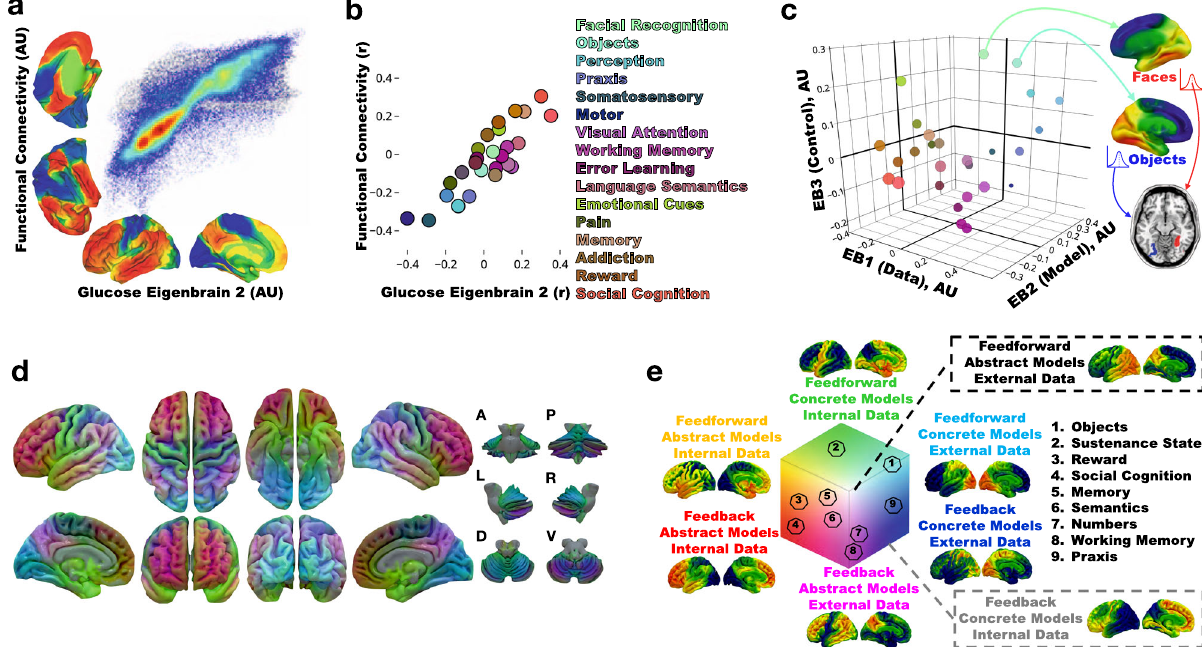
Fig. 3 Global information processing interpretation of low-dimensional degenerative patterns in dementia. a Joint histogram between the principal axes of functional connectivity 37 and glucose EB2. b Neurosynth decoding of the principal axes of functional connectivity versus glucose EB2 decoding. Select topic terms are color-coded on the right (color coding is the same as in c ). c Scatter plot of topic term decoding for glucose EB1-3. Source data are provided in Supplementary Table 1. For the color-coding, each EB decoding was used as a RGB channel (EB1 = Blue, inverted polarity EB2 = Red, EB3 = Green). Radius of the points encodes depth along EB2. Generated anatomy using the 10-D EB decoded coordinates for faces and objects are displayed on the right and left hemisphere (respectively) surface renderings. Below these, axial brain slice with the peak voxels from the faces and objects anatomic projection overlaid highlighting regions near the fusiform face area (red) and visual word form area (blue) respectively encoded at these points. d The same RGB color-coding was applied in a voxel-wise manner using the intensities from EB1-3 producing a continuous functional parcellation of brain anatomy along these gradients. e The global information processing state space representation of the same color mapping with the approximate location of nine cognitive topic terms from panel c overlaid and numbered. A surface rendering of the anatomic correlates, generated from linear combinations of EB1-3 weighted by the position in state space, for the eight extremes of the cube are displayed near the portion of state space represented. AU-arbitrary units; A-anterior; P- posterior; L-left lateral; R-right lateral; D-dorsal;